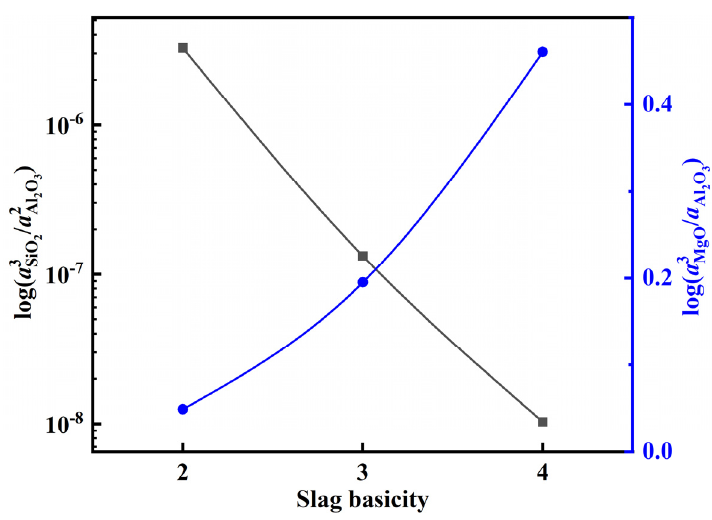
3 / a 2 ) and log ( a 3 SiO 2 Al 2 O 3